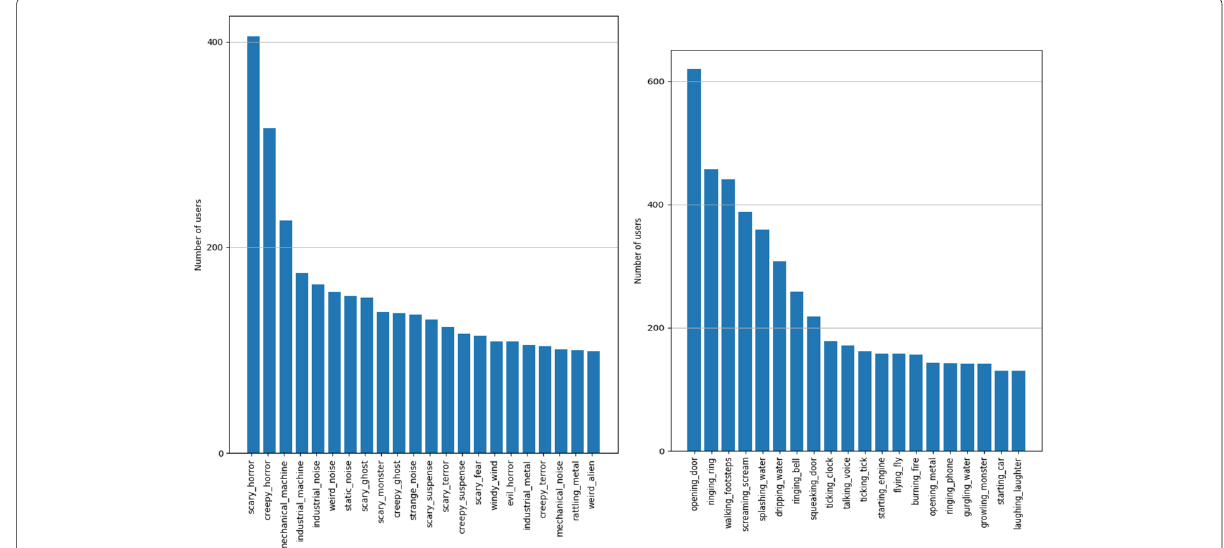
Fig. 5 Number of users per pair. Number of users that uploaded files for ANPs (left) and VNPs (right). We show examples of pairs with at least 400